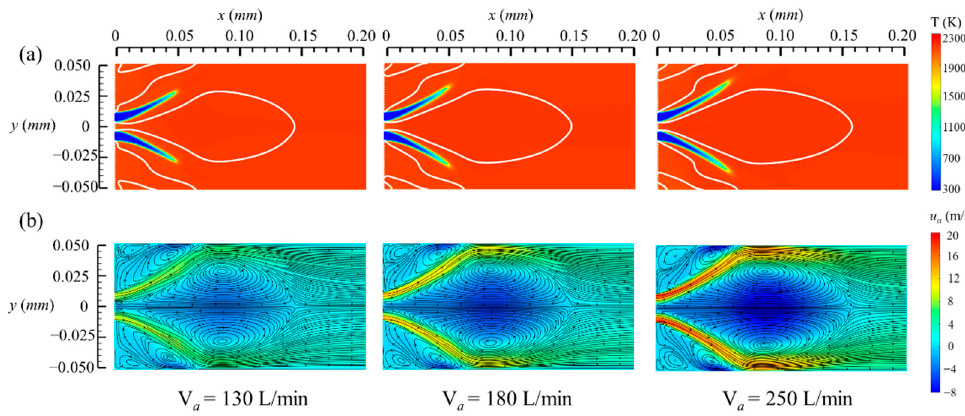
Figure 7. ( a ) Temperature contour along with zero axial velocity isolines, and ( b ) axial velocity contour along with the streamlines of different V a , where S N = 0.45 and T i = 300 K.